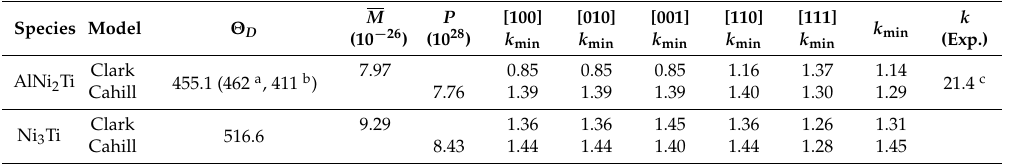
P k M [100] [010] [001] [110] [111] k min k min k min k min k min k min (10 28 ) (10 − 26 )